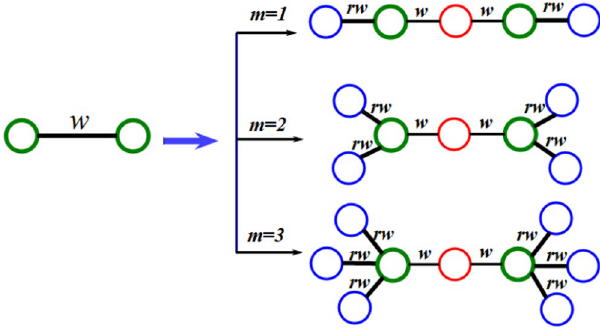
Figure 1. Iterative construction method on every edge for the weighted scale-free treelike networks for three special cases of m = 1, m = 2, and m = 3, where each blue node represents a new external node, while each red node stands for a new internal